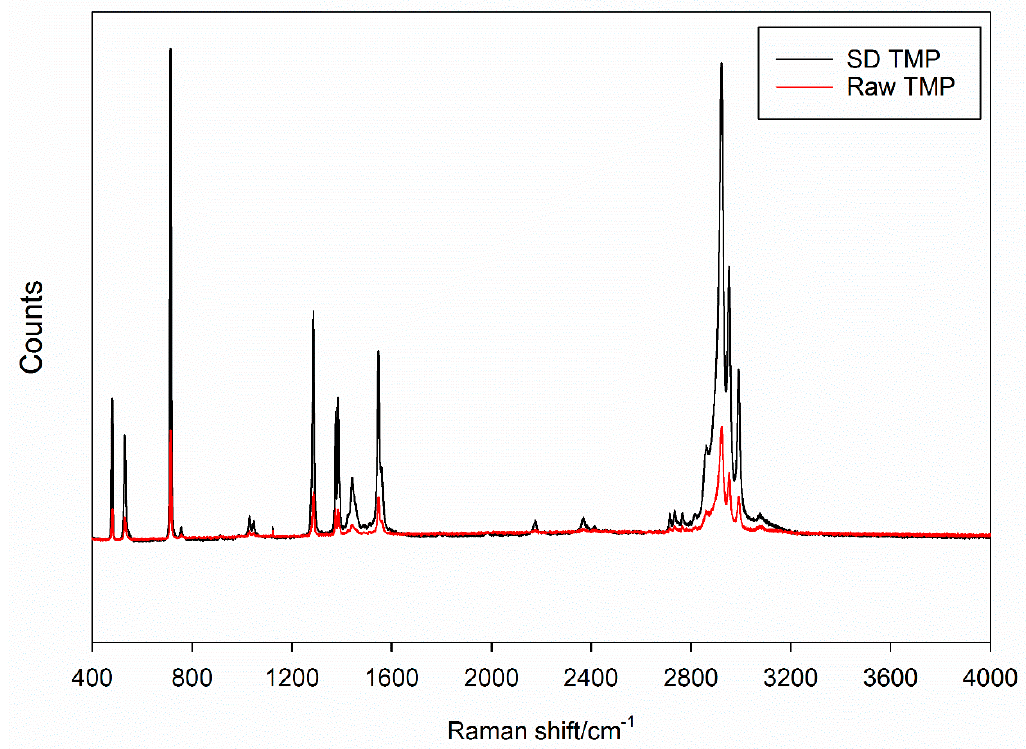
Figure 6. Raman spectra of raw TMP and spray dried (SD) TMP.